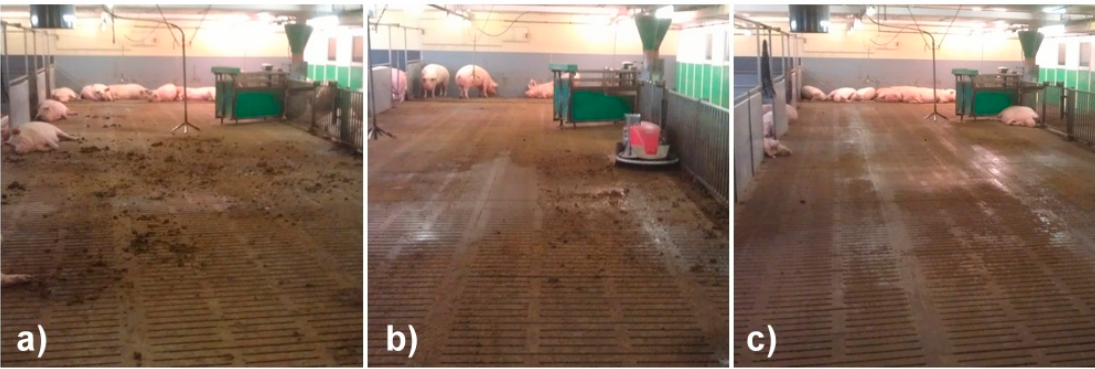
Figure 4. Condition of floor area before ( a ), during ( b ) and after cleaning ( c ) in experimental